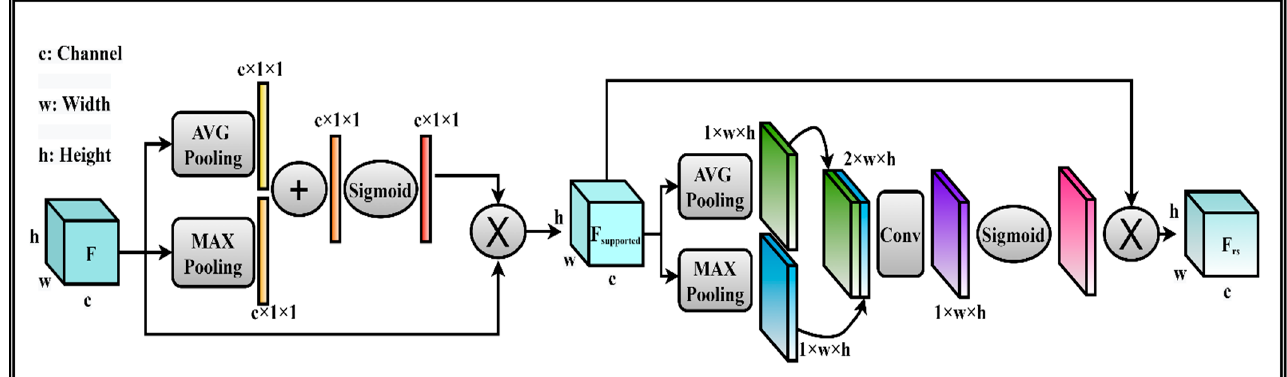
Figure 1. The proposed spatial attention module.